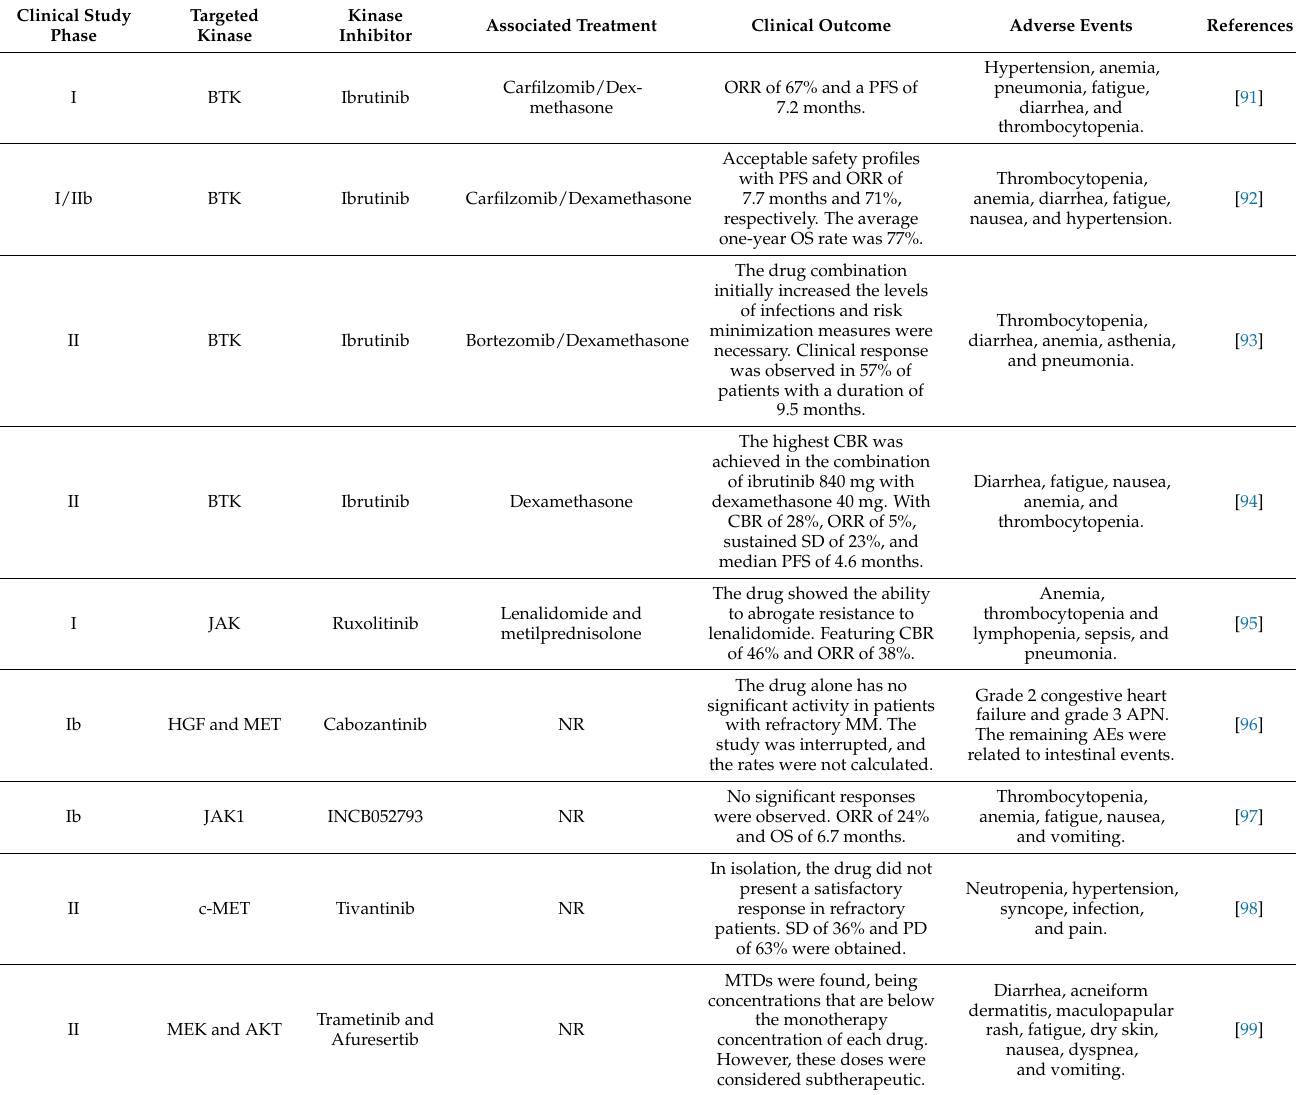
Table 1. TKIs used in clinical trials to treat refractory multiple myeloma in the last 10